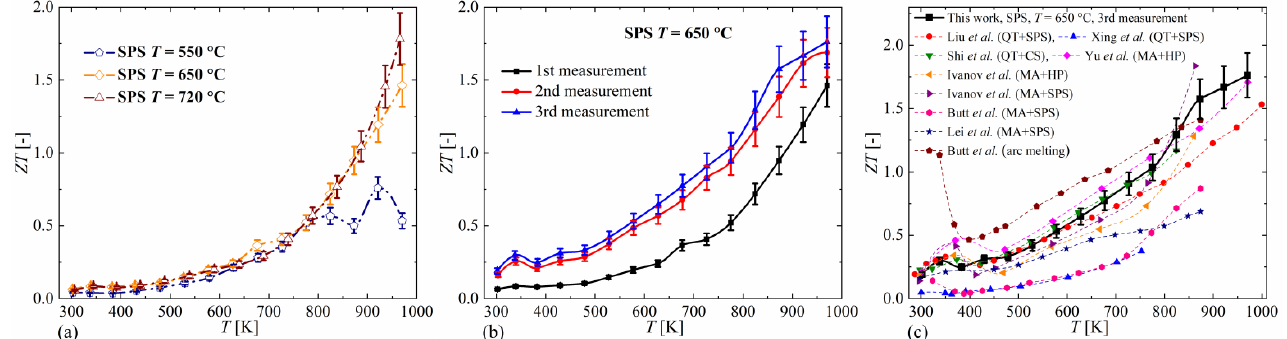
Figure 7. Temperature dependence of ZT parameter for Cu 2 Se samples sintered at different temperatures ( a ), for different measuring cycles for the sample sintered at 650 °C ( b ) and for the sample sintered at 650 °C with literature data ( c ) (absolute errors for α r = 0.10), MA-mechanical alloying, QT-high temperature synthesis in quartz tube, SPS-spark plasma sintering, HP-hot pressing, CS-conventional sintering.